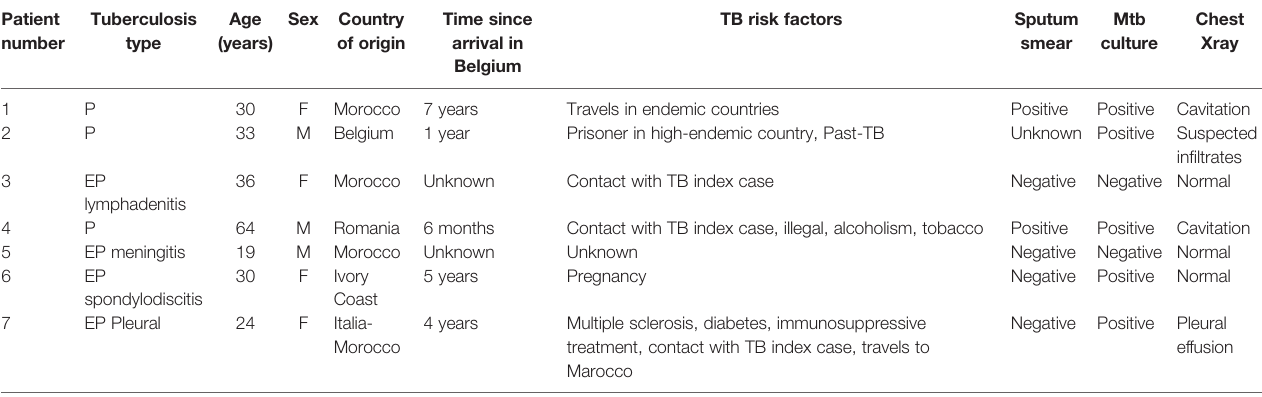
TABLE 2 | Demographic and clinical data of the misclassi fi ed aTB patients from the training cohort.